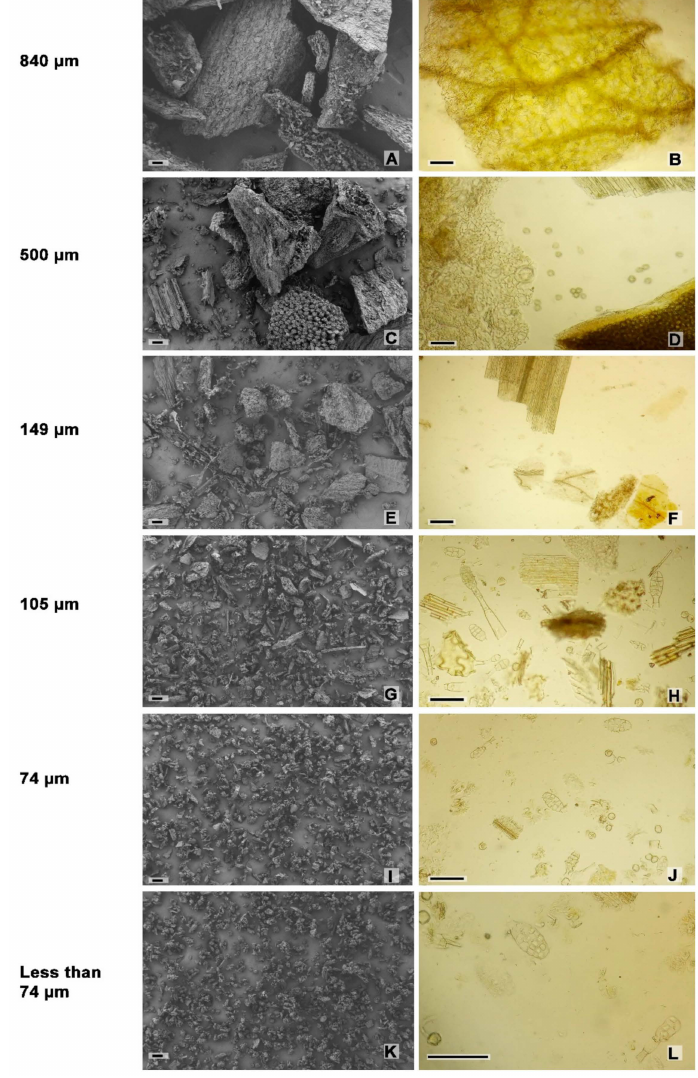
Figure 5. Nicotiana tabacum var. Virginia. Sieved fractions from ground flowers. ( A , C , E , G , I , K ) SEM. ( B , D , F , H , J , L ) Optic microscopy. ( A , B ) 840 µ m. ( C , D ) 500 µ m. ( E , F ) 149 µ m. ( G , H ) 105 µ m. ( I , J ) 74 µ m. ( K , L ) less than 74 µ m. Scales: ( A – L ) 100 µ